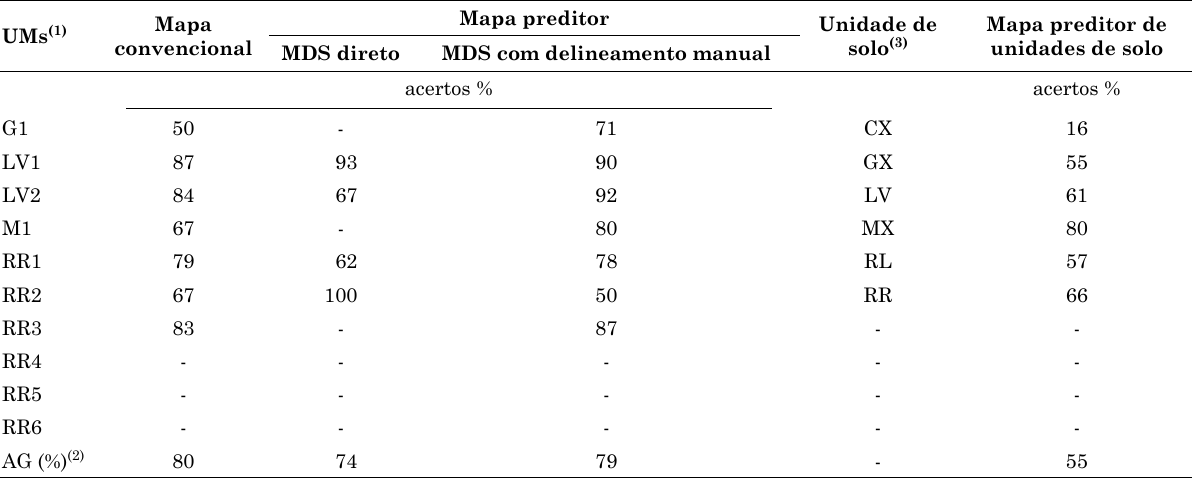
Quadro 2. Avaliação da acurácia pela “verdade de campo” no mapa de solos convencional, no